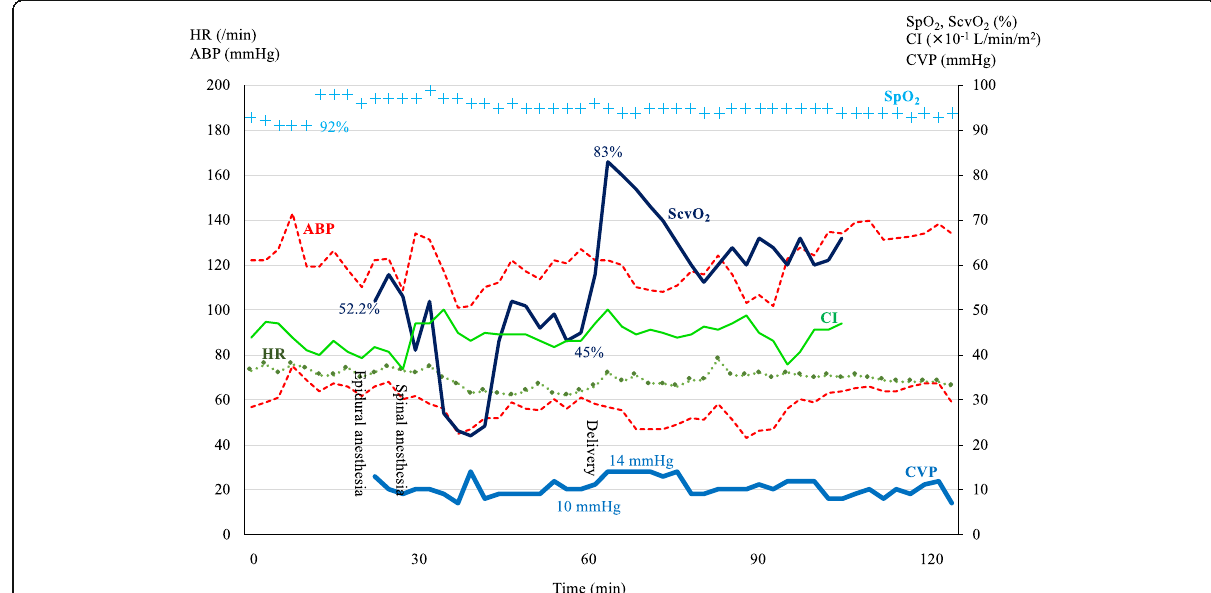
Fig. 1 Trend of hemodynamic parameters during anesthesia. HR, heart rate; ABP, arterial blood pressure; SpO 2 , percutaneous oxygen saturation; ScvO 2 , central venous oxygen saturation; CI, cardiac index; CVP, central venous pressure